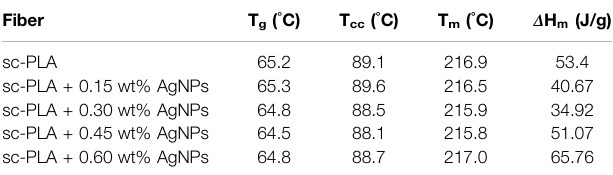
TABLE3| Thermalpropertiesofelectrospun fi bersofsc-PLA,sc-PLA+0.15 wt% AgNPs, sc-PLA +0.30 wt%AgNPs,sc-PLA+0.45 wt%AgNPs,and sc-PLA + 0.60 wt% AgNPs.